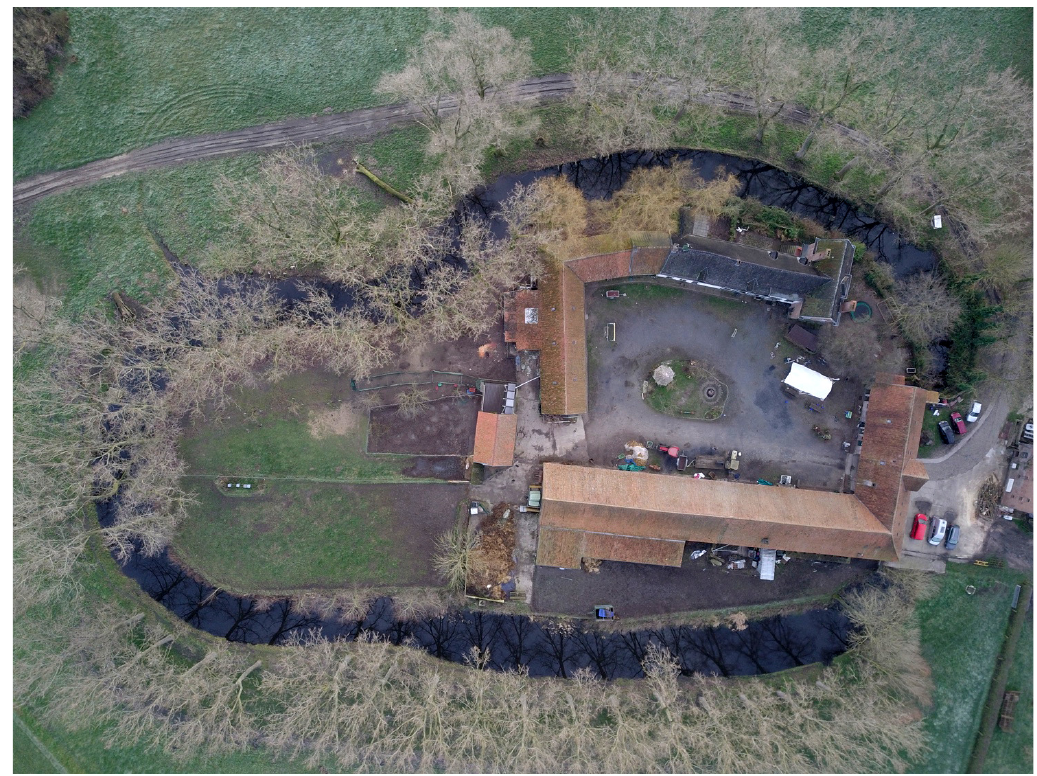
Figure 2. Moated farmstead in Heule. Source: Courtesy of E. Falomo, J. Hallaj, and E. Froelich (personal communication, 16 December 2020).